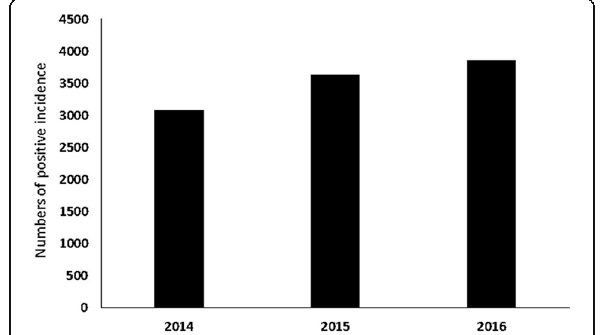
Fig. 1 Number of dengue cases reported from the 16 local hospitals in Bandung from 2014 to 2016. Hotspot analysis helps in identifying clustered data points on a map. Therefore, using this method permits the averaging of the results, based on cumulative monthly averaging or seasonal averaging